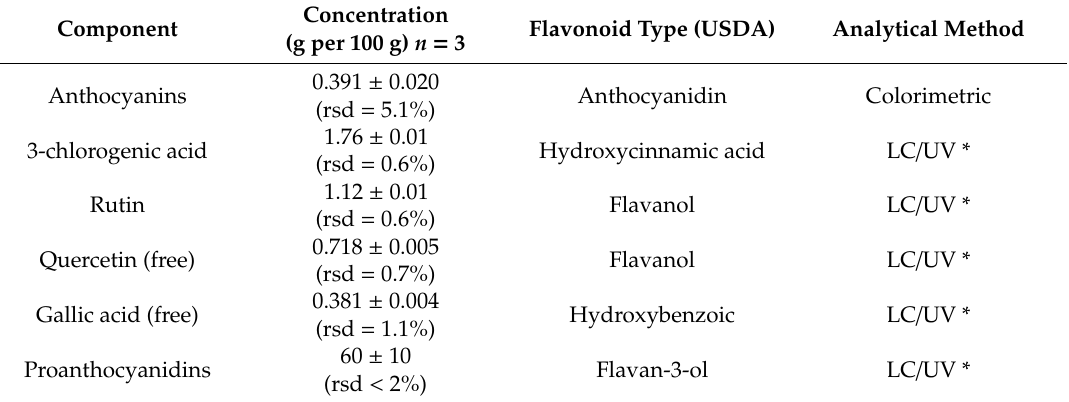
Table 1. Characterization of composition of polyphenol-enriched plum extract (PE60).